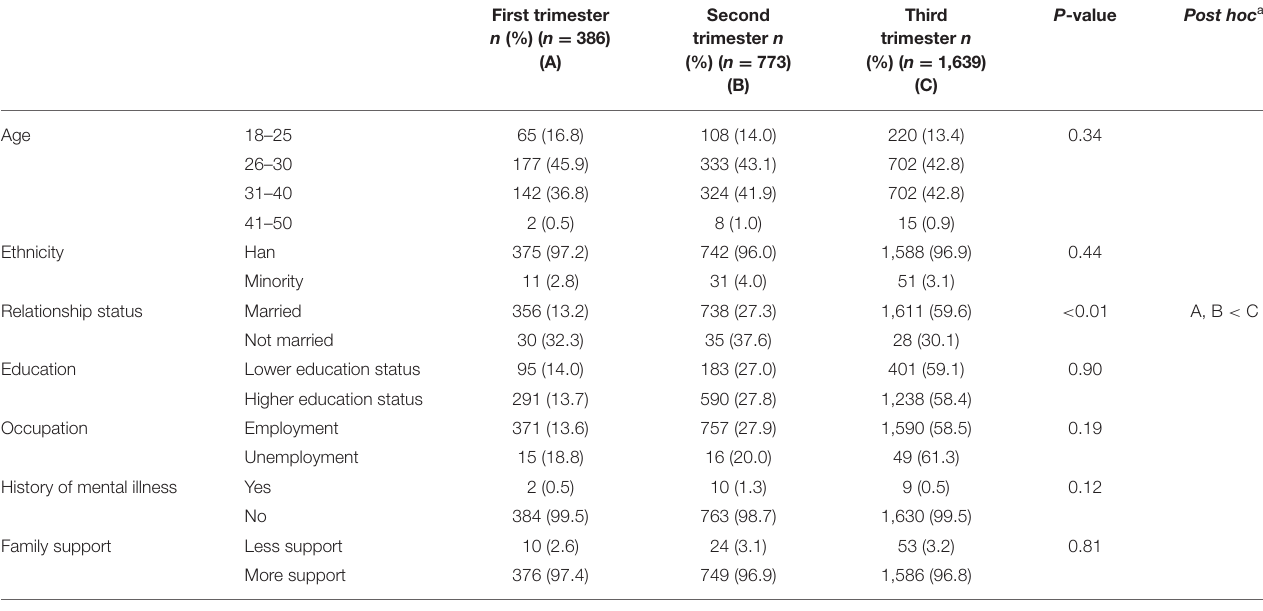
TABLE 1 | Socio-demographic characteristics of pregnant women among pregnancy trimester during the COVID-19 pandemic.